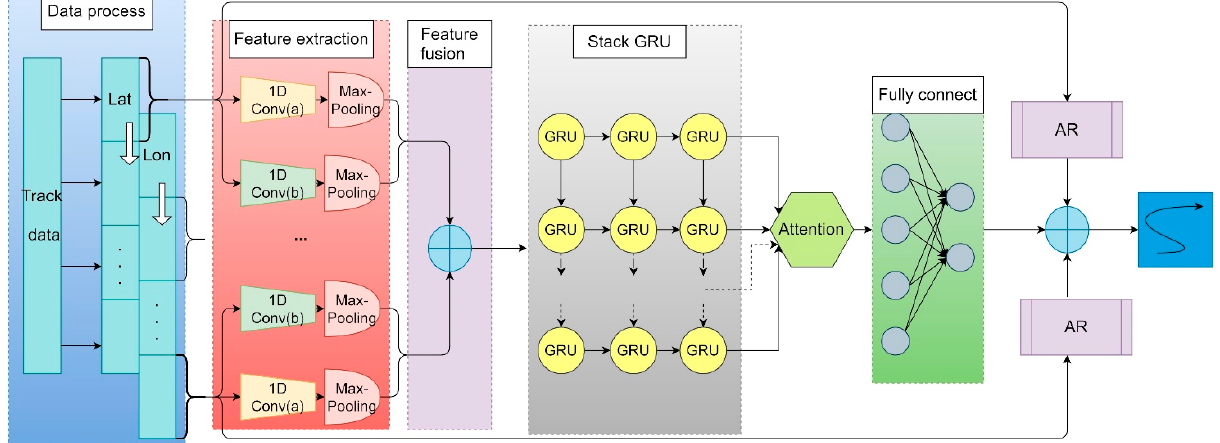
Figure 5. Network structure of the proposed model.